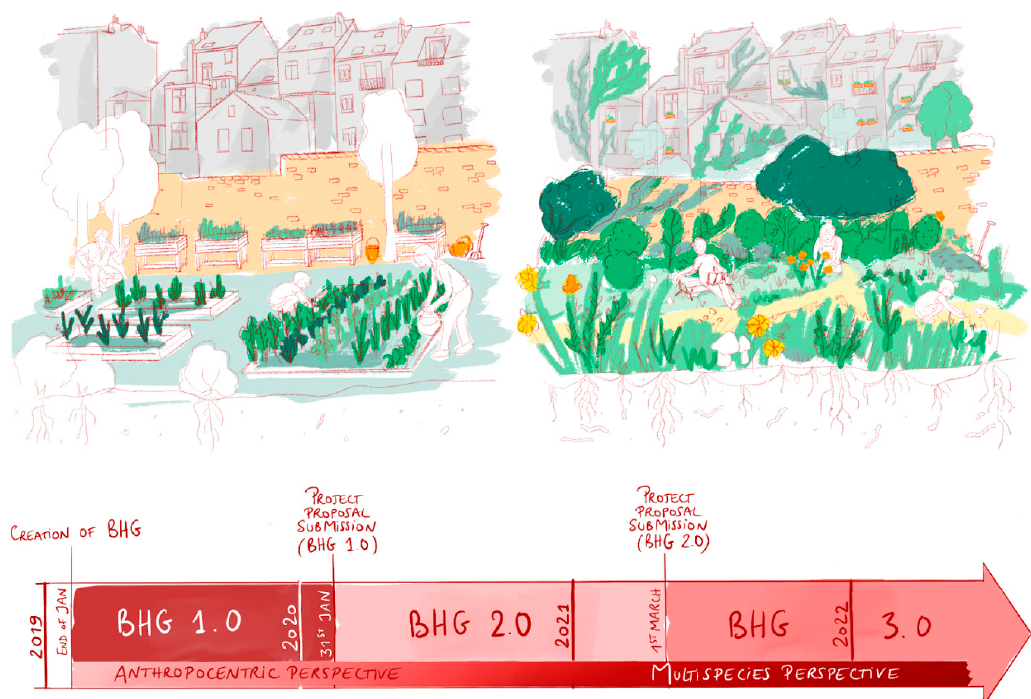
Figure 1. The development and timeline of the BHG project. Graphical work by graphic designer Juliette Nguyen.